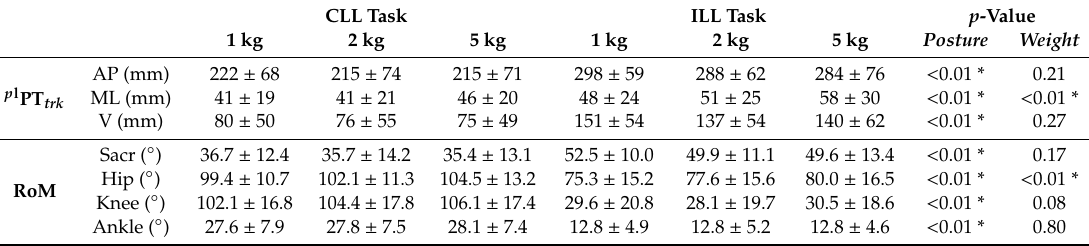
Table 1. Mean, standard deviation, and p- values of the main e ff ects Posture and Weight of a 2 x 3 two-way repeated measures ANOVA for the three components of the p l PT trk vector (the displacement in the 3D space between the pelvis and trunk body segments); the range of motion of the lumbosacral joint and the right lower limb joints estimated through the biomechanical model (BM) in the correct lifting loads (CLL) and incorrect lifting loads (ILL) tasks. * marks significant di ff erences.